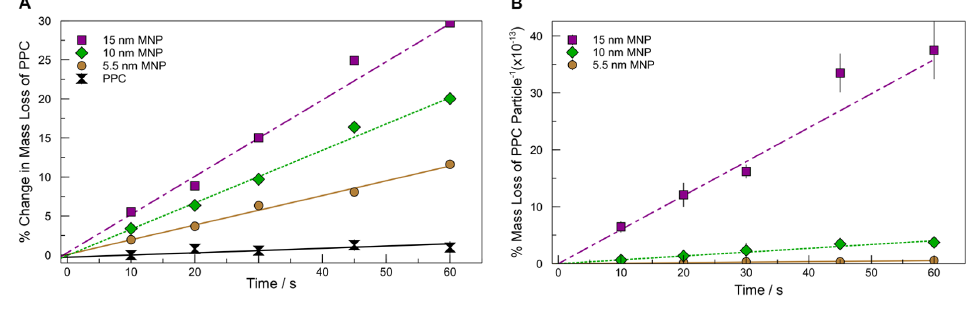
Figure 3. ( A ) Percent mass loss over time for MNP and neat PPC; ( B ) Percent of PPC decomposed for a single particle over